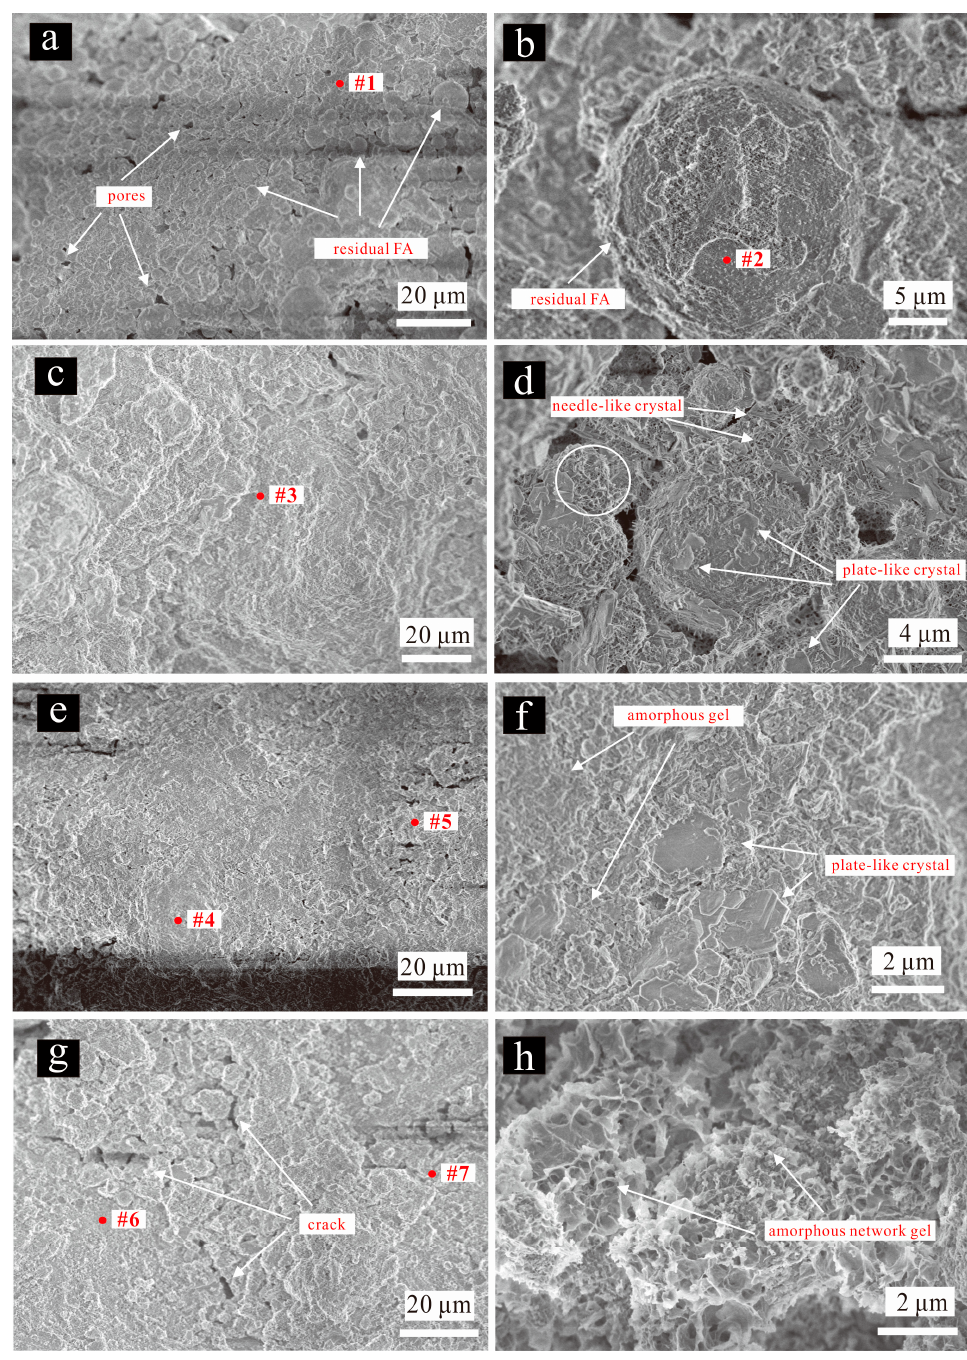
Figure 8. The SEM images of FA/CCR-based geopolymers. ( a , b ) FA2CCR1-0.4-50 °C; ( c , d ) FA1CCR1-0.4-50 °C; ( e , f ) FA1CCR2-0.4-50 °C; ( g , h ) FA1CCR2-0.4-80 °C.